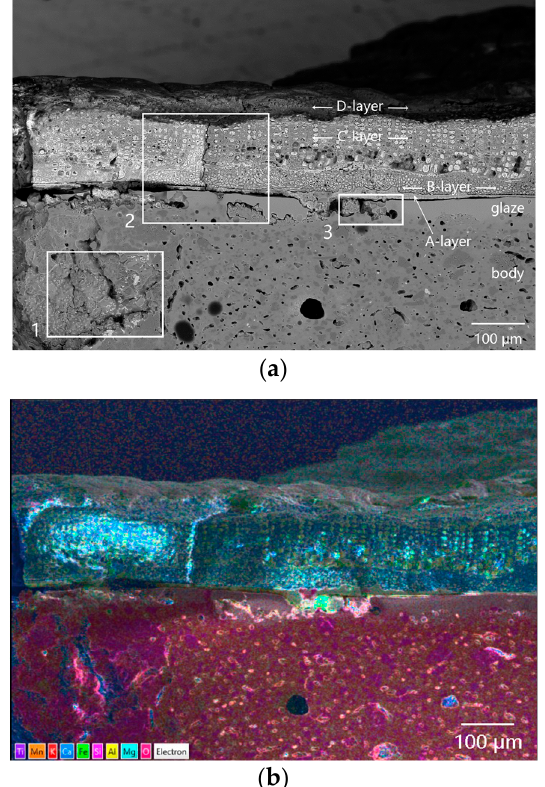
Figure 8. Cross-sectional morphology of the cellular-structure coagula attached to sample DL-1: ( a ) SEM image and ( b ) element mapping images.